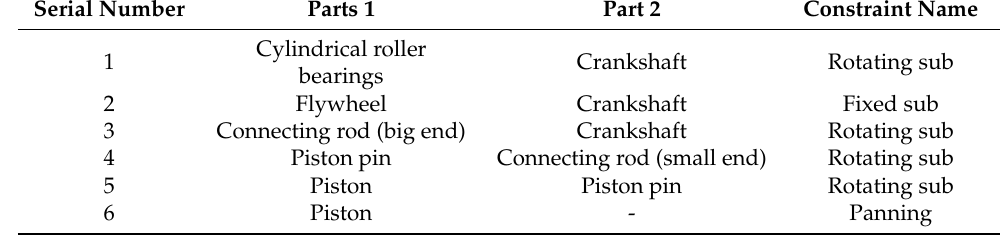
Figure 9. Rigid point se tt ing of the fl exible body.